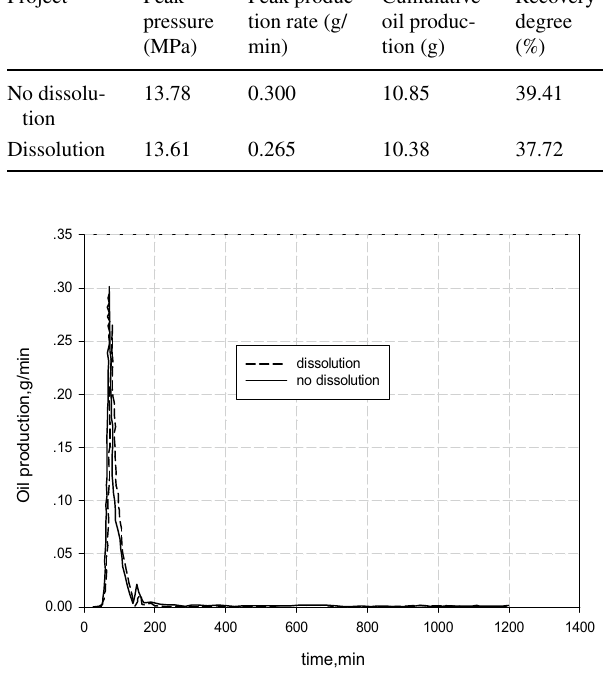
Fig. 12 Oil production rate curve contrasting dissolution and no dis-